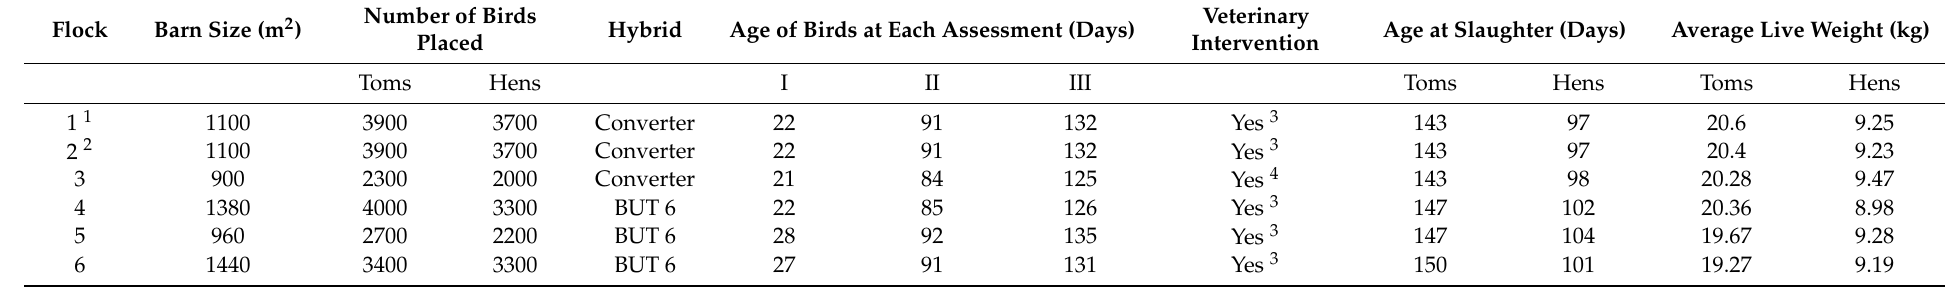
Table 1. Information relating to flocks of turkeys: number of birds and hybrids, age of birds at each assessment, veterinary treatment, age, and average live weight at slaughter. Number of Birds Flock Barn Size (m 2 ) Hybrid Age of Birds at Each Assessment (Days) Placed